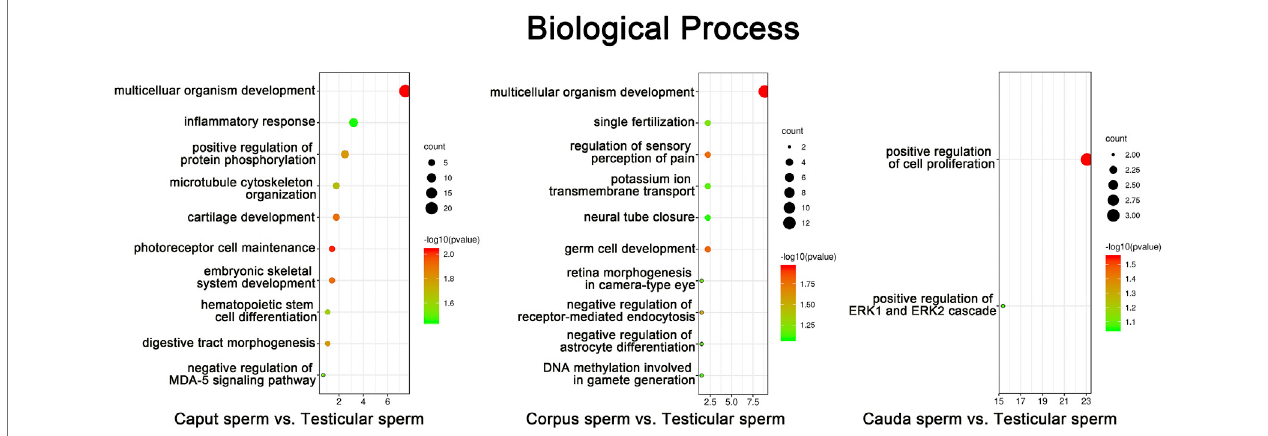
FIGURE 5 | Gene Ontology (GO) enrichment analysis of sperm methylation changes identi fi ed during post-testicular maturation. CpG methylation sites from promoter regions that presented the highest signi fi cant changes among spermatozoa from different segments (% change > 25, Q value < 0.05) were submitted to GO analysis.Thetoptenmostsigni fi cantenrichedbiologicalprocessGOtermsarepresented( p < 0.05).Thecolorandsizeofeachpointrepresentsthe-log10(FDR)values and enrichment scores, respectively. A higher -log 10 (FDR) value and enrichment score represents a greater degree of enrichment.